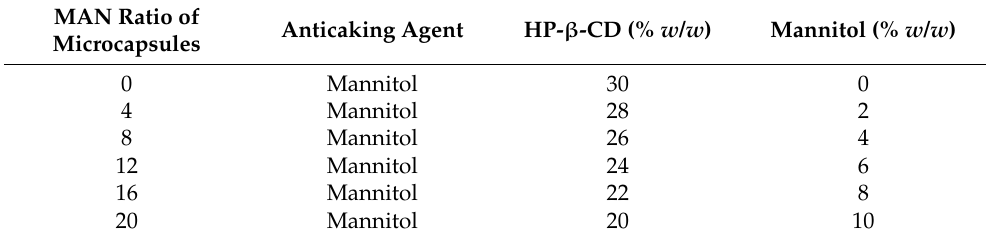
Table 3. Wall material ratio of hydroxypropyl- β -cyclodextrin (HP- β -CD)/mannitol (MAN) microcap- sules with different MAN